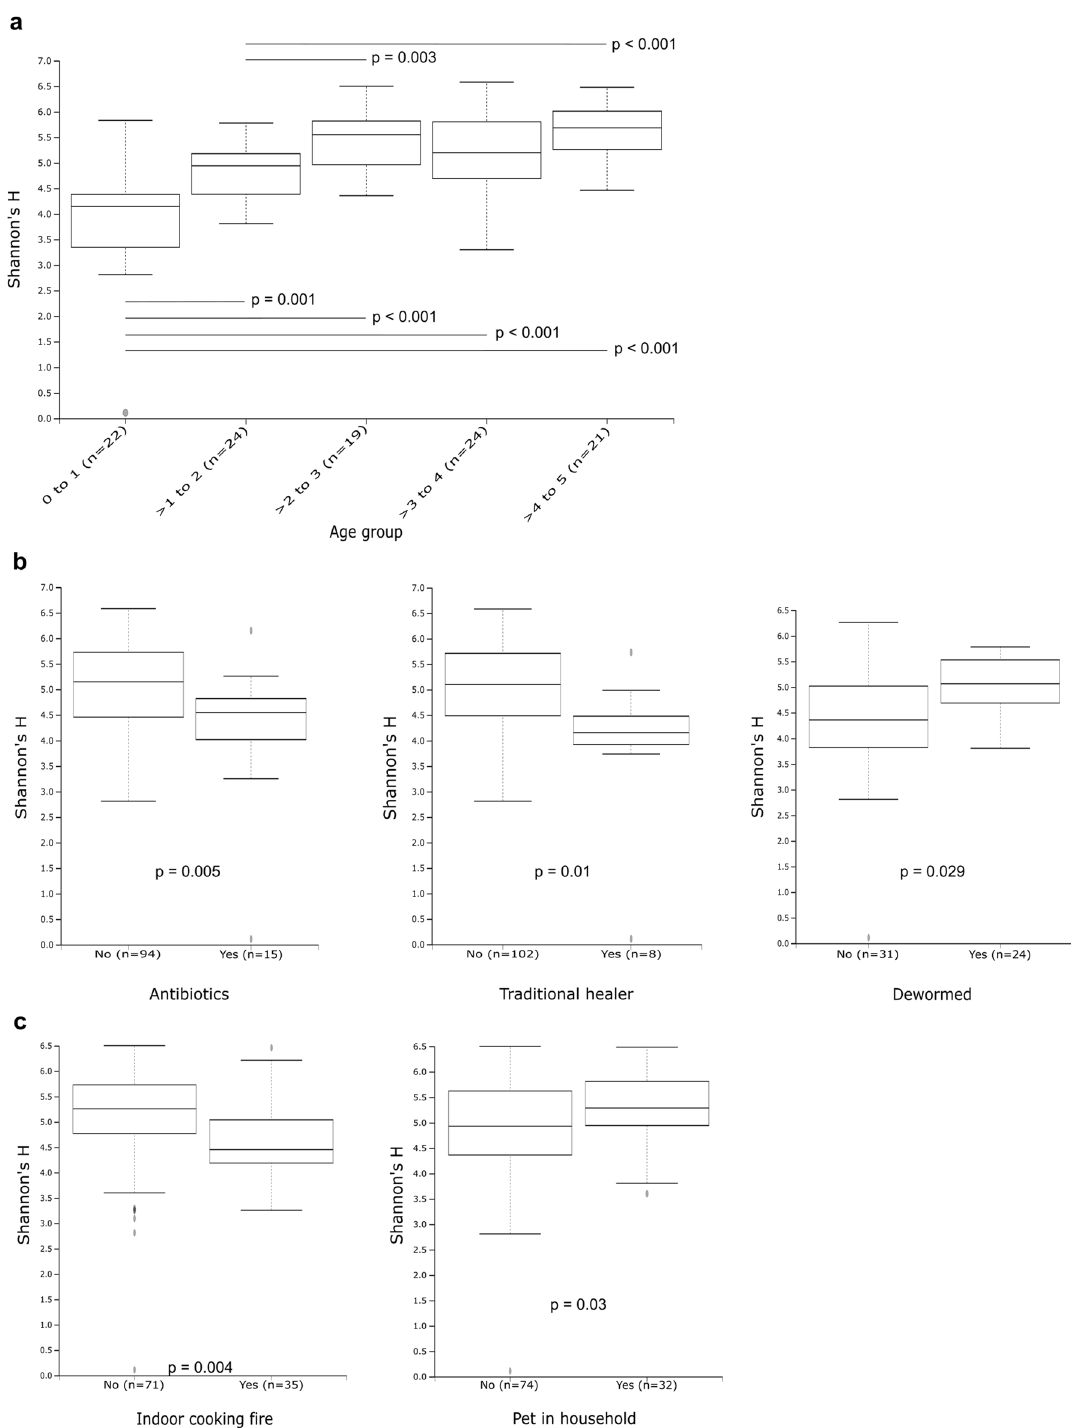
Figure 3. Shannon’s H alpha diversity plotted for significant factors (p < 0.05). ( a ) Age bands separated by year of life. Lines indicate significant differences between the groups at each end of the line. There were no significant differences between the groups representing the oldest three age bands. ( b ) Clinical factors, including receipt of antibiotics within 2 weeks from sample collection, treatment from traditional healer within 3 years from sample collection, and deworming within 6 months from sample collection. ( c ) Environmental factors, including exposure to an indoor cooking fire using paraffin or wood, and exposure to pets in the household (cats/dogs). Faith’s PD results have been summarised in Supplementary Table